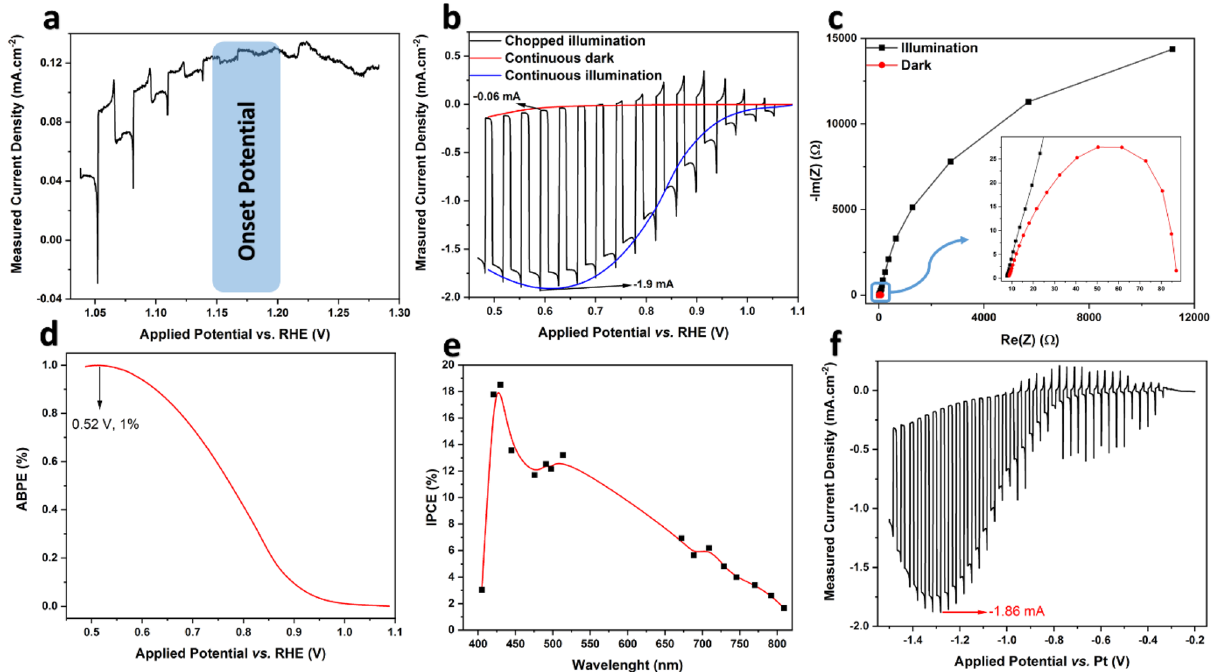
Figure 6. Photoelectrochemical results of the film electrode made from heat-treated (at 400 °C for 5 min) NiO-doped CuO nanoflakes employed in 2 M KOH solution and under illumination intensity of AM 1.5 G; ( a ) photocurrent (j–V) plot of the film at low current density for identification of onset potential, ( b ) three-electrode photocurrent plot of the film, the scanning rate of 20 mV s −1 and chopped light illumination at ~ 0.5 Hz frequency, ( c ) Nyquist plot of the film at − 0.3 V versus SCE under illumination and in dark conditions, in the frequency range of 0.1 Hz to 0.1 MHz under 10 mV AC amplitude, ( d ) calculated functional bias photon to electron conversion efficiency (ABPE) of the film electrode extracted from the data obtained from continuous illumination and continuous dark conditions [see ( b )], ( e ) photon incident to current conversion effectiveness (IPCE) for the film electrode at − 0.3 V versus SCE, and ( f ) two-electrode photocurrent plot of the